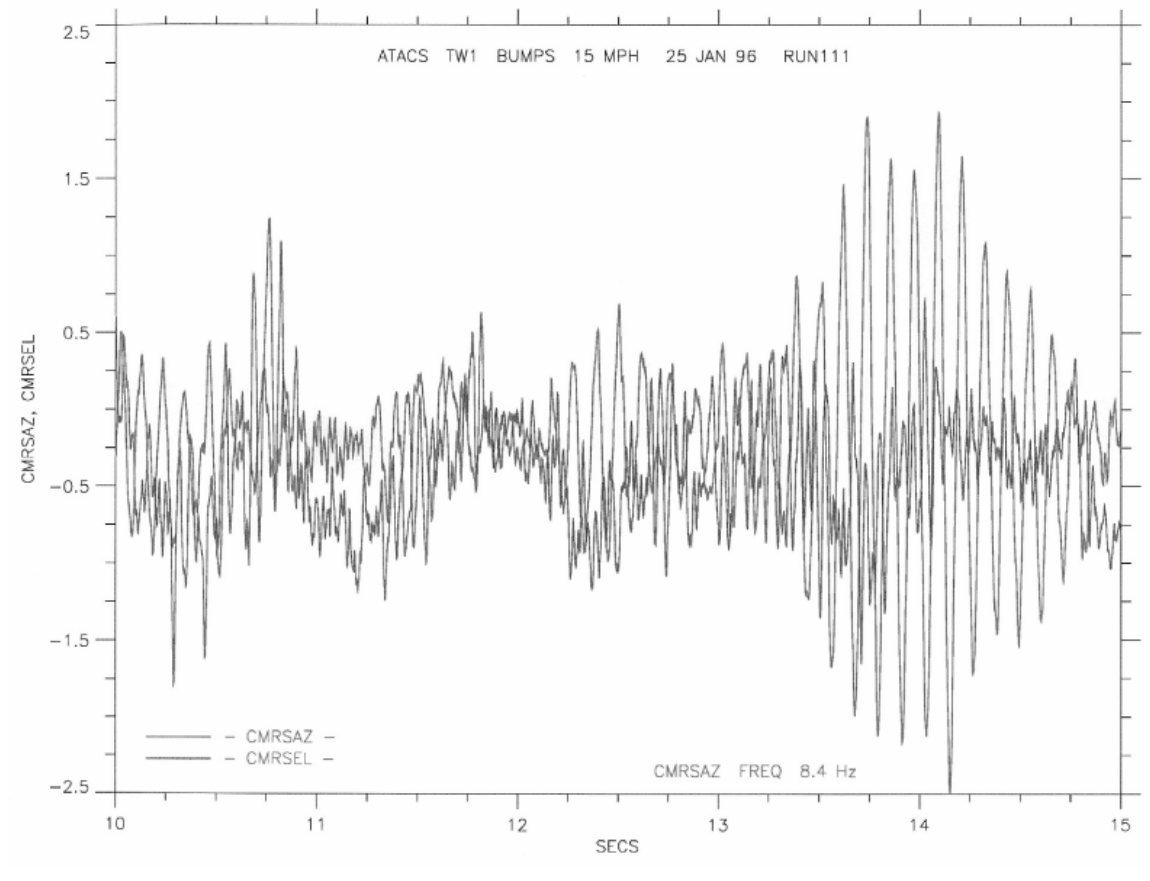
Fig. 5. CMRS azimuth and elevation time history, detail